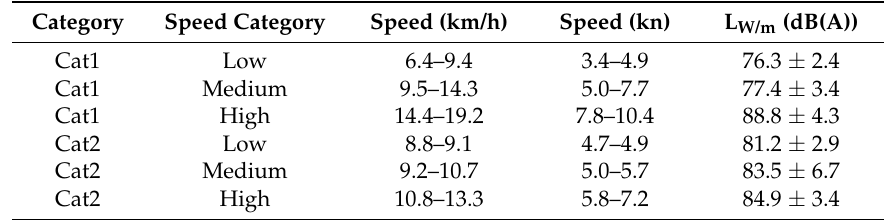
Table 2. Summary of the obtained L W/m and 1/3 octave band sound power spectra for different category and speeds of small